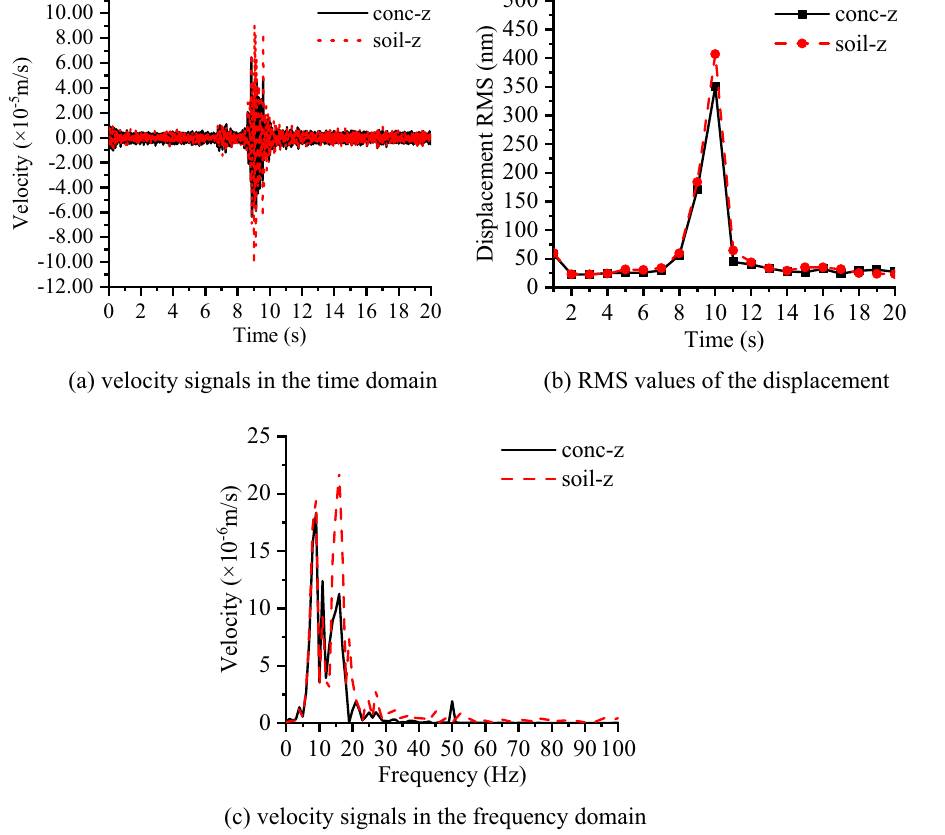
Figure 8. Signals in the time domain and frequency